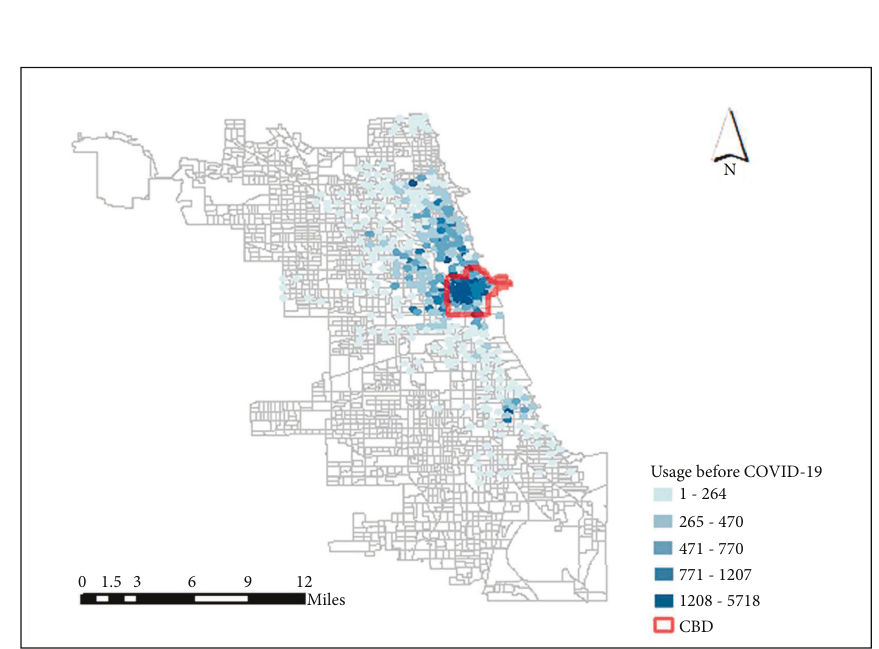
Figure 5: Spatial distribution of Divvy usage before